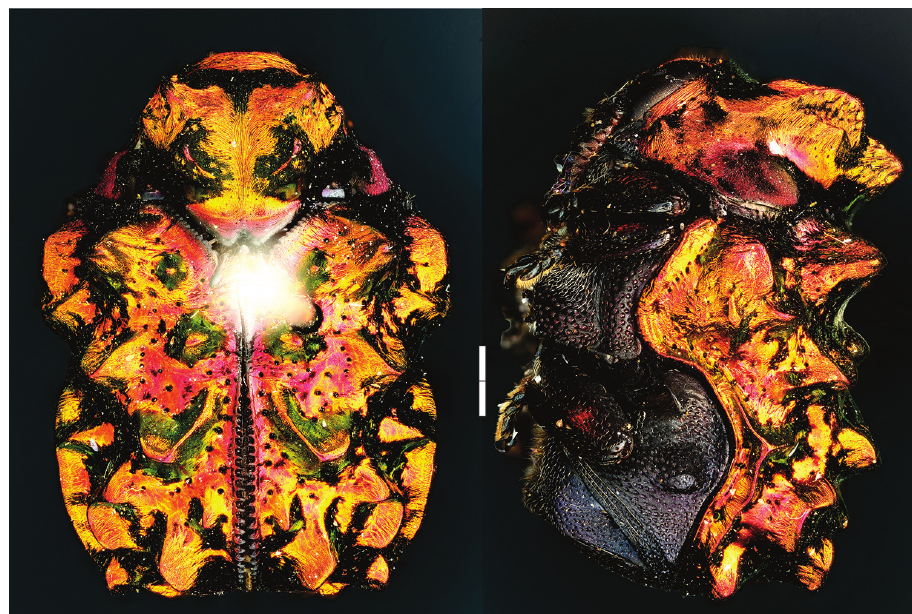
Figure 31. Fulcidax bacca (Kirby) (2) , left: habitus (dorsal view), right: habitus (lateral view).